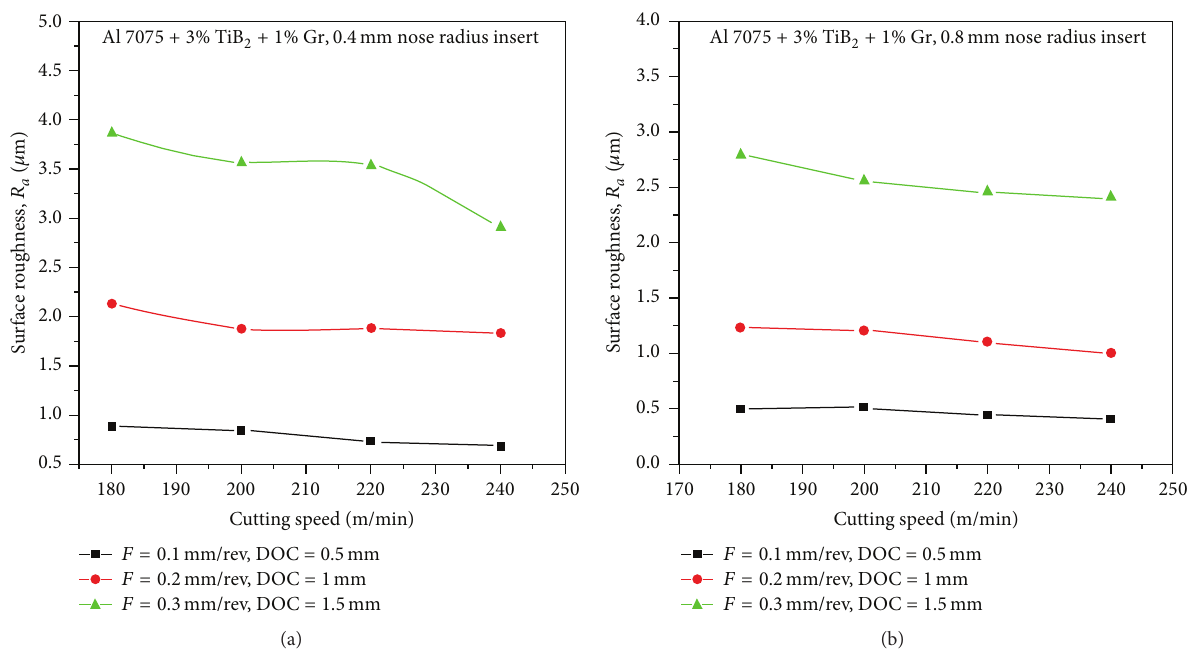
Figure 9: Variations of surface roughness on 0.4 mm and 0.8 mm nose radius of Al 7075 + 3% TiB 2 -1% Gr